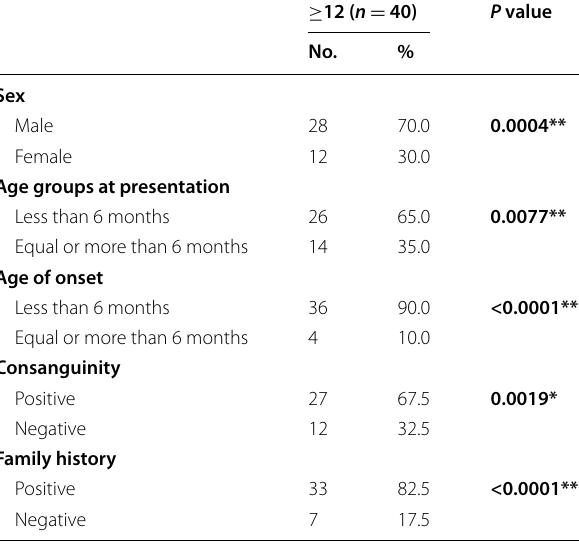
Table 1 Sociodemographic data and family history of atopy of